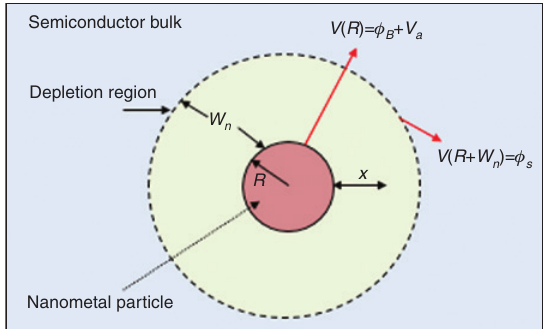
Figure 2: A schematic showing the top view (2D model) of a hemi- spherical nanoparticle embedded in the surface of a semiconductor substrate